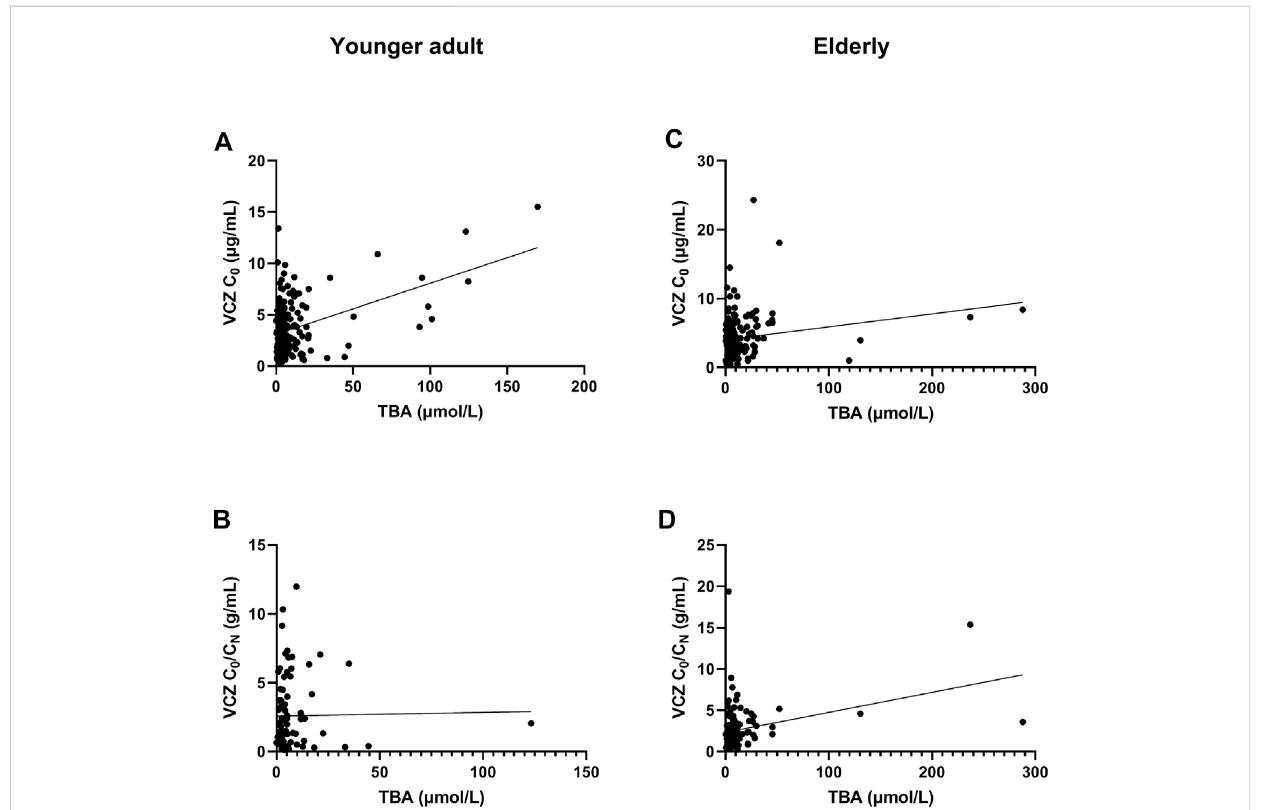
FIGURE 1 Association of total bile acid (TBA) level with voriconazole (VCZ) trough concentration (C 0 ) and VCZ-to-VCZ N-oxide concentration ratio (C 0 /C N ). (A) . The TBA level was positively associated with VCZ C 0 in younger adult patients; (B) . There was no association between TBA level and VCZ C 0 /C N in youngeradultpatients; (C) .TherewasapositiveassociationbetweenTBAlevelandVCZC 0 inelderlypatients; (D) .TheTBAlevelwaspositivelyassociated with VCZ C 0 /C N in elderly